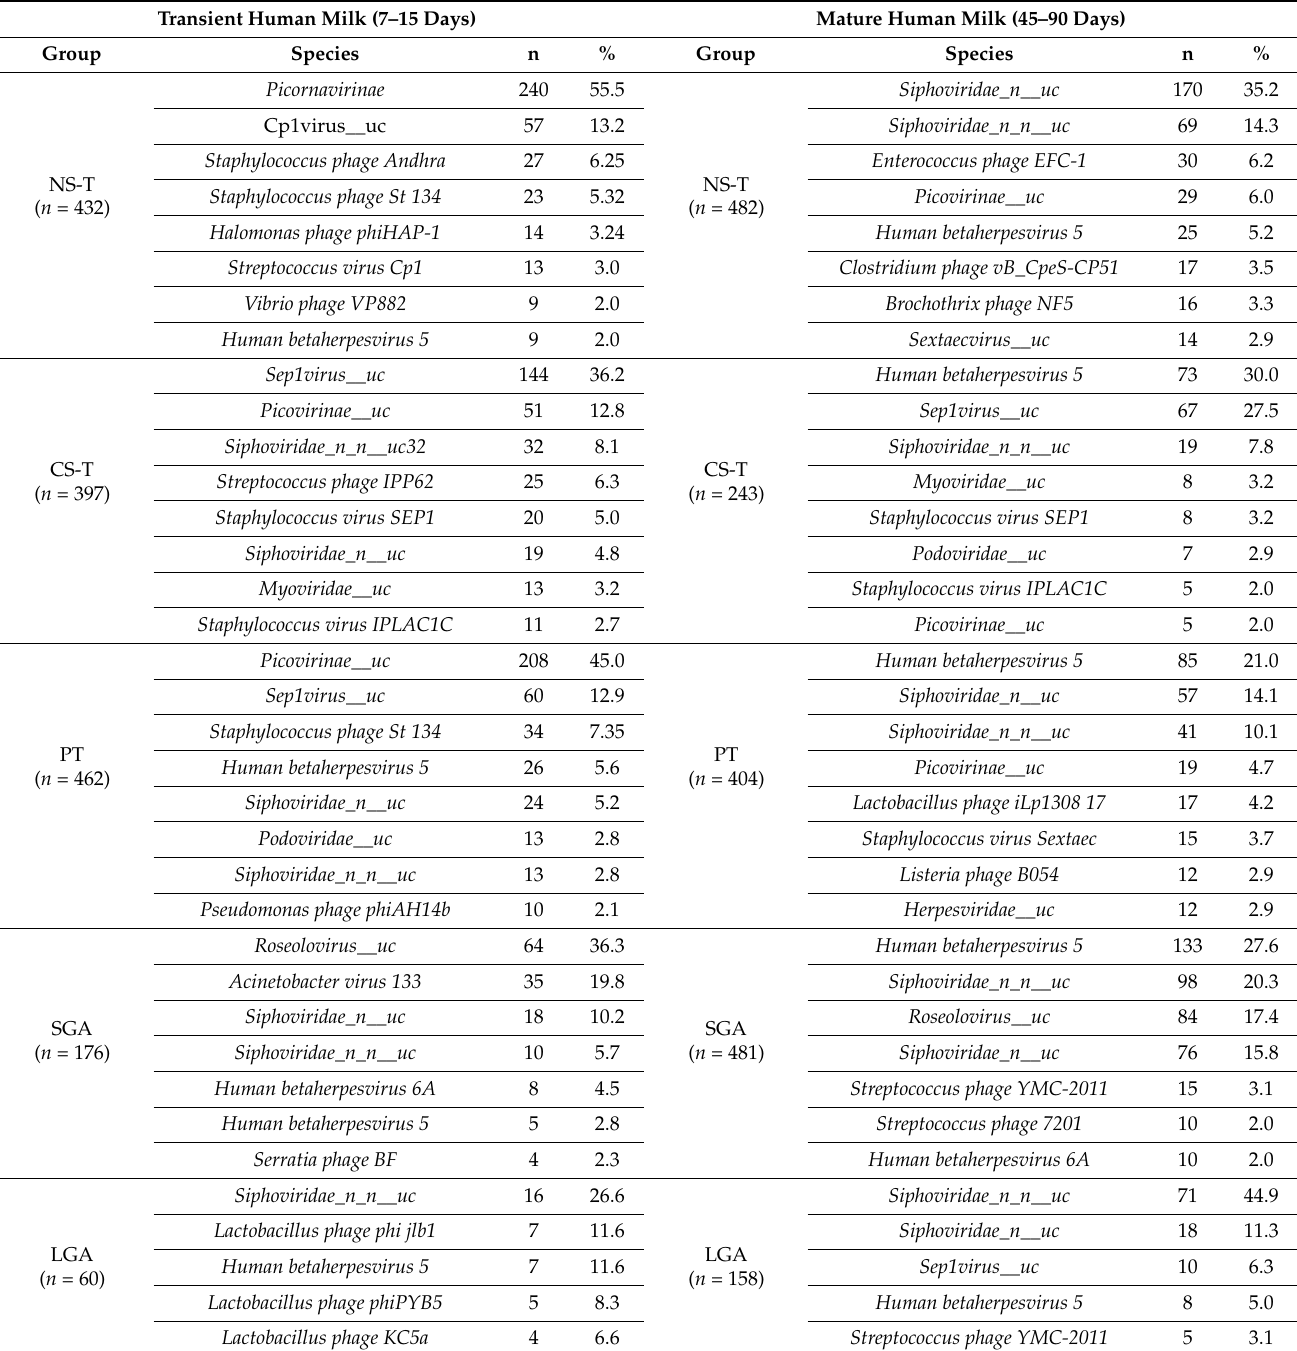
level, and in MMS, Herpesviridae (48.8%) at the family level and Human betaherpesvirus 5 (27.6%) at the species level. In the LGA group, Siphoviridae was the predominant family in both TMS (41.6%) and MMS (65.8%), and Siphoviridae _n_n__uc was the most abundant species in both TMS (26.6%) and MMS (44.9%) (Table 2, Figure 1). Table 2. Most abundant viruses at species level in transient and mature human milk samples based on delivery type, prematurity, and birth weight for gestational